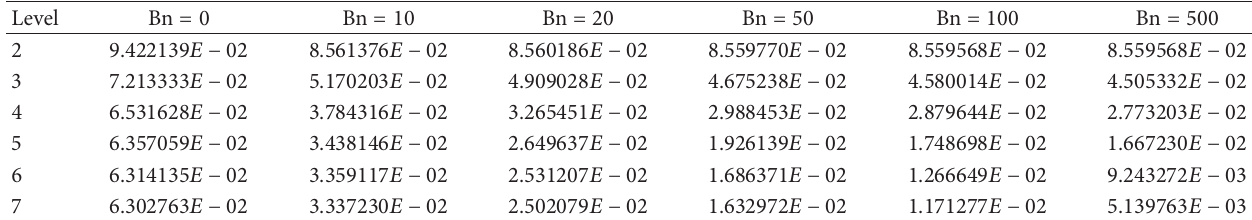
Table 3: Kinetic energy for double lid driven cavity at different Bingham numbers